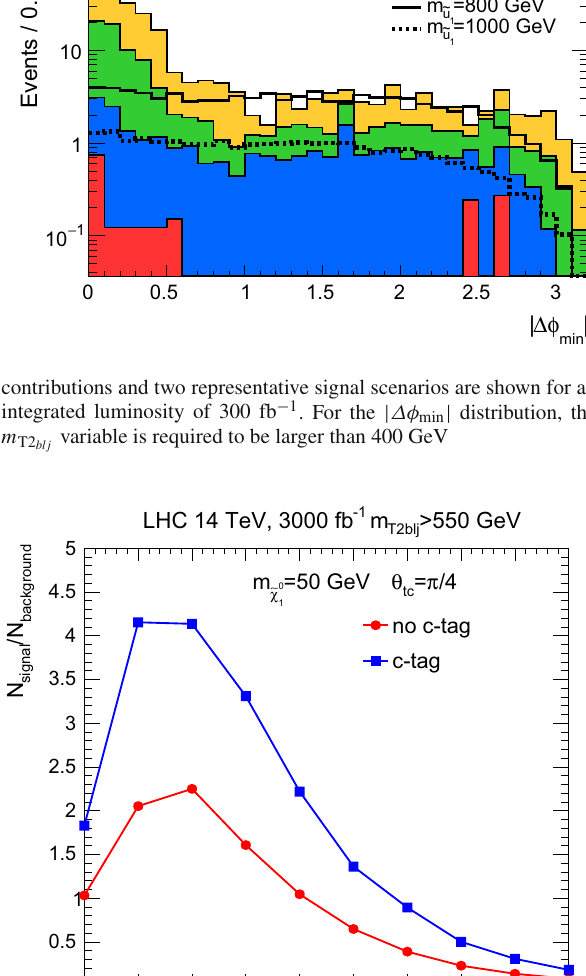
( S / B )onthesquarkmass m ˜ u